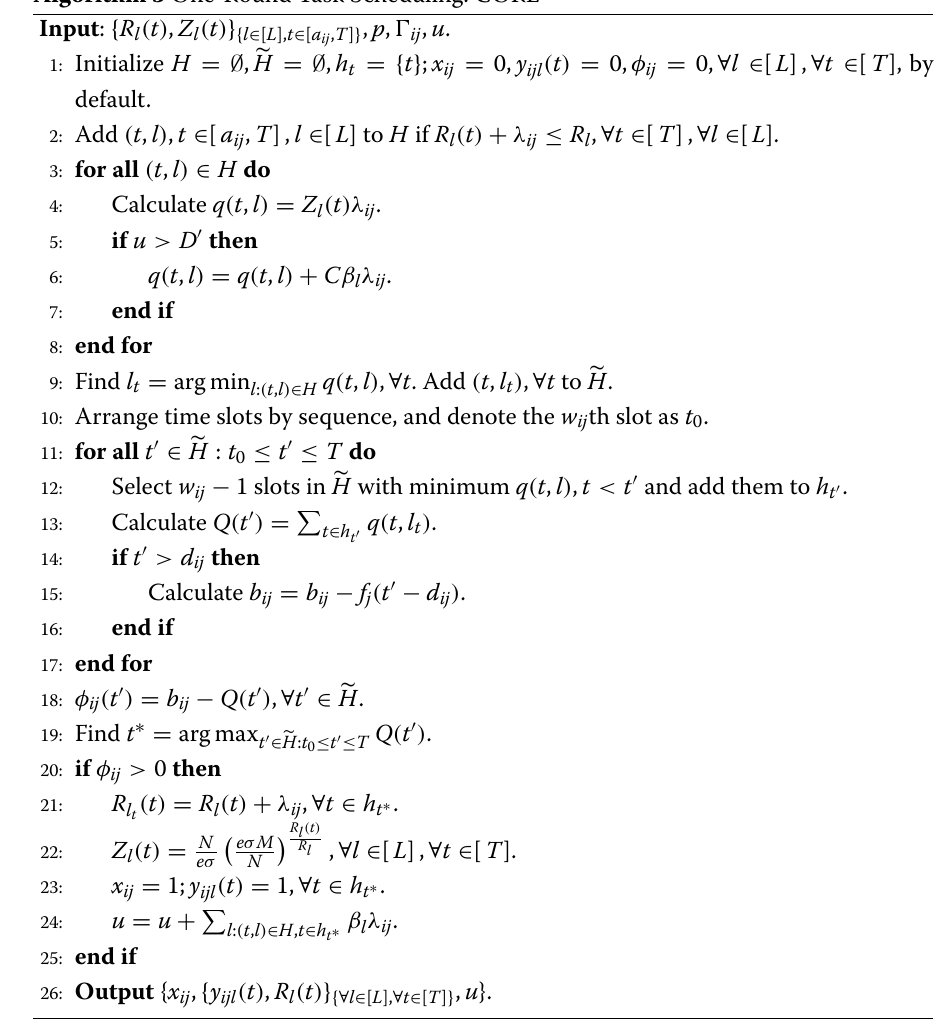
Algorithm 3 One-Round Task Scheduling: